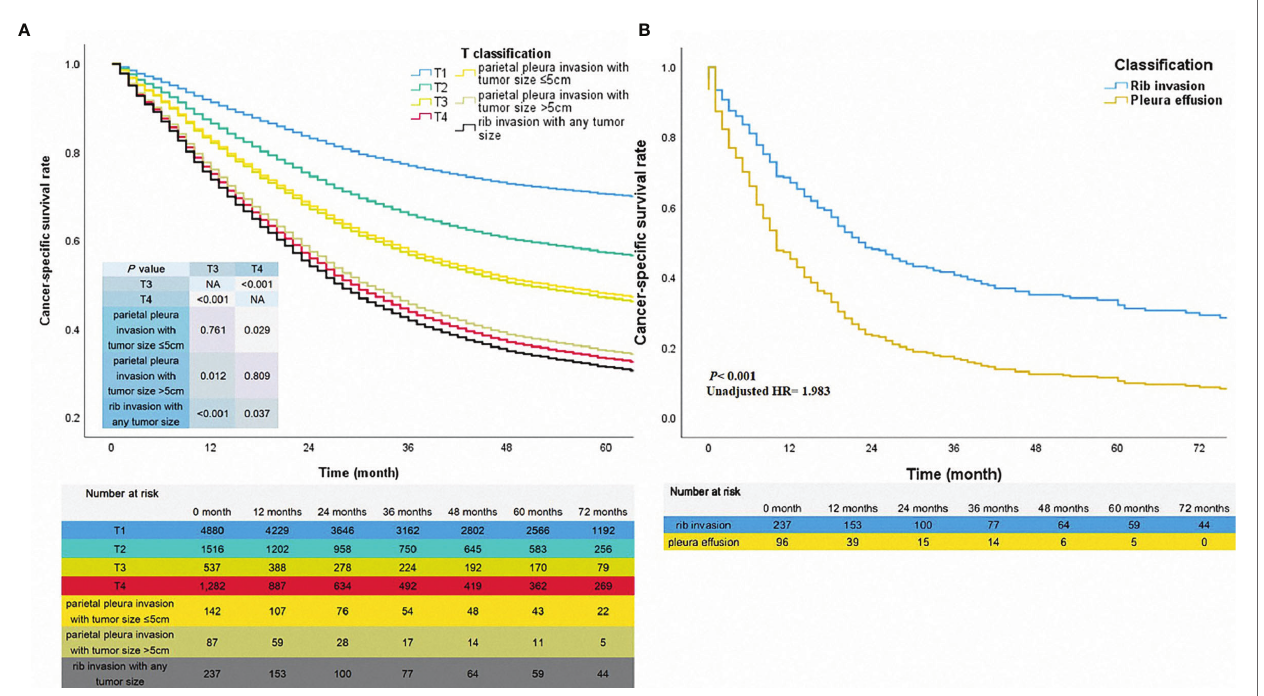
FIGURE 3 | The adjusted survival curves of different pathological T classi fi cations and chest wall invasion (A) . The unadjusted survival curves for pleura effusion (TxN0M1a) and rib invasion (B)